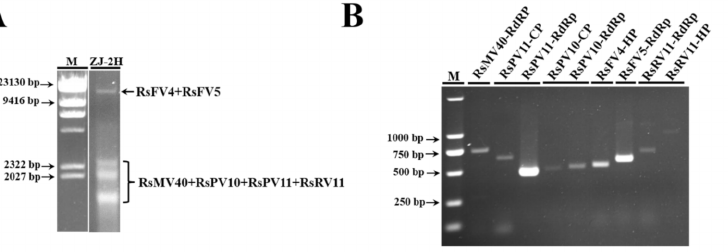
Figure 1. Identification of mycoviruses in Rhizoctonia solani AG-3 PT strain ZJ-2H. ( A ) Multiple bands of double-stranded RNA (dsRNA) extracted from R. solani AG-3 PT strain ZJ-2H were visualized by 1% agarose gel electrophoresis and subsequently purified. M: λ - Hind III digest; ZJ-2H: dsRNA extracted from R. solani AG-3 PT strain ZJ-2H. ( B ) Products of reverse transcription-polymerase chain reaction (RT-PCR) using viral-specific primers designed based on the nucleotide sequences of RNA dependent RNA polymerase (RdRp), coat protein (CP), or hypothetical protein (HP) in the six mycoviruses. Products were visualized and purified by 1% agarose gel electrophoresis. Total RNA was extracted from R. solani AG-3 PT strain ZJ-2H and used as an RNA template in RT-PCR. M: DNA molecular marker DL